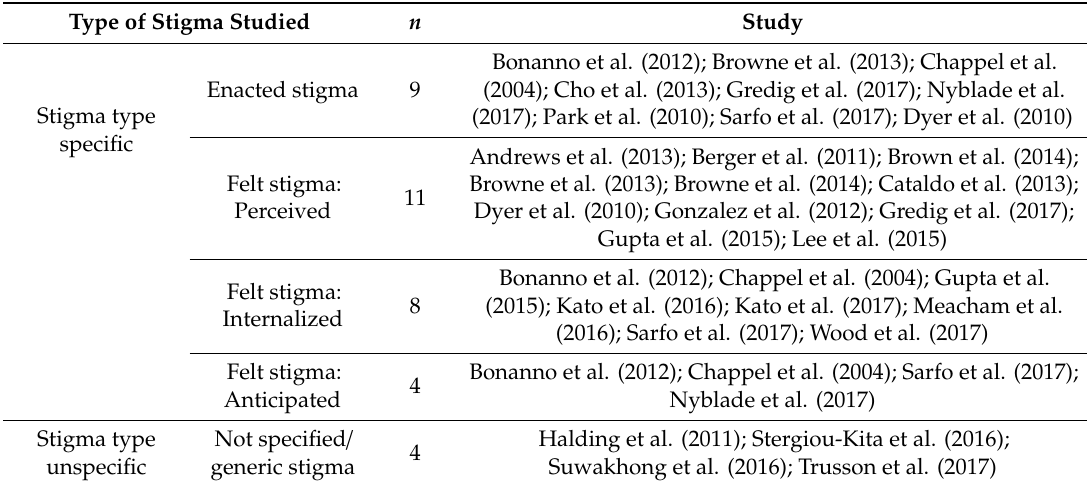
Table 1. Types of stigma explored in the